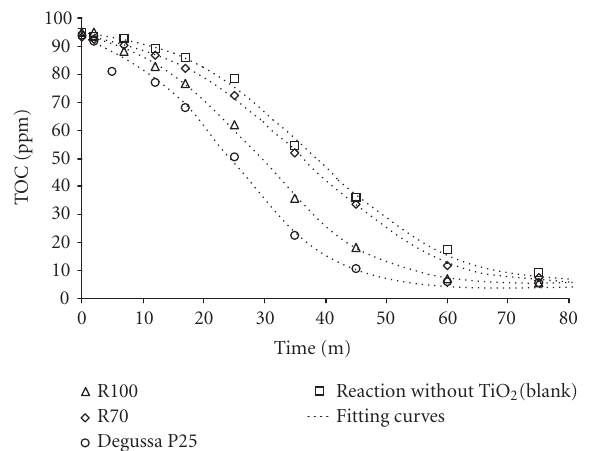
Figure 8: Photoinduced degradation of phenol with stoichiometric H 2 O 2 , catalysed by the following TiO 2 catalysts: ( Δ ) R100, ( ♦ ) R70, (O) Degussa P25. The symbol ( (cid:3) ) indicates that the reaction was carried out without TiO 2 (blank). Dotted lines represent the fitting curves.